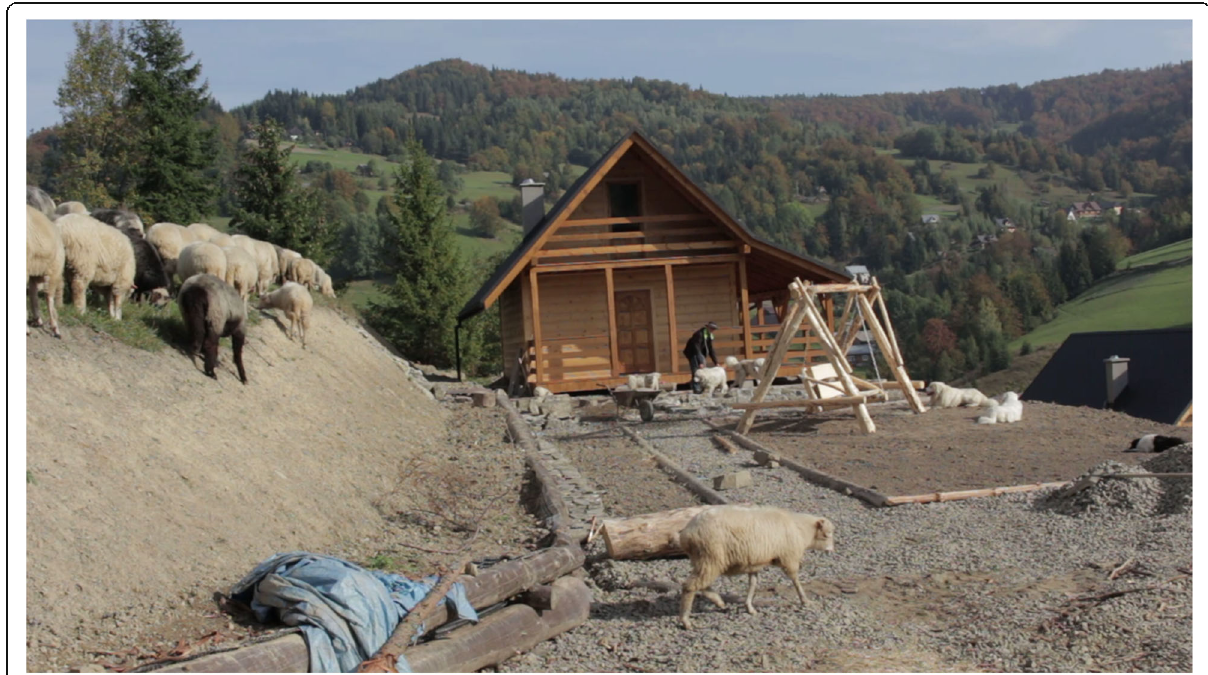
Figure 4 ‘ Second homes ’ situated mid-slope above Ochotnica